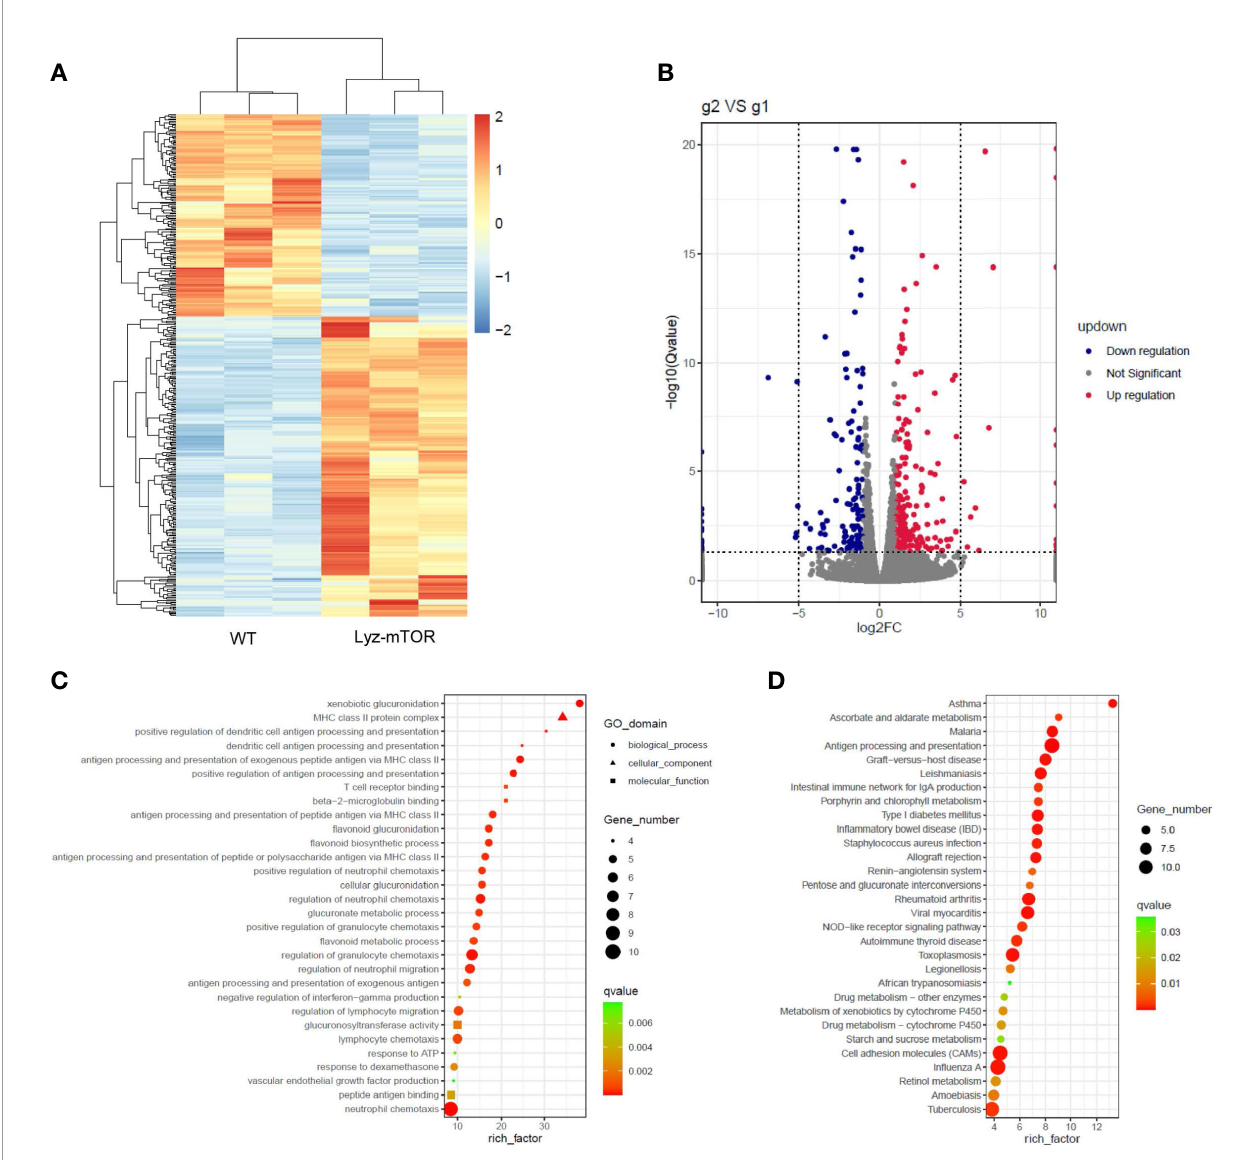
FIGURE 4 | RNAseq analysis of WT and mTOR − / − M-MDSCs: DEGS, GO enrichment, and KEGG pathway. (A) DEG heat map. (B) DEG volcano plot. (C) DEG GO enrichment analysis, including biological process, cellular component, and molecular function. (D) Main KEGG pathways (n = 3 per